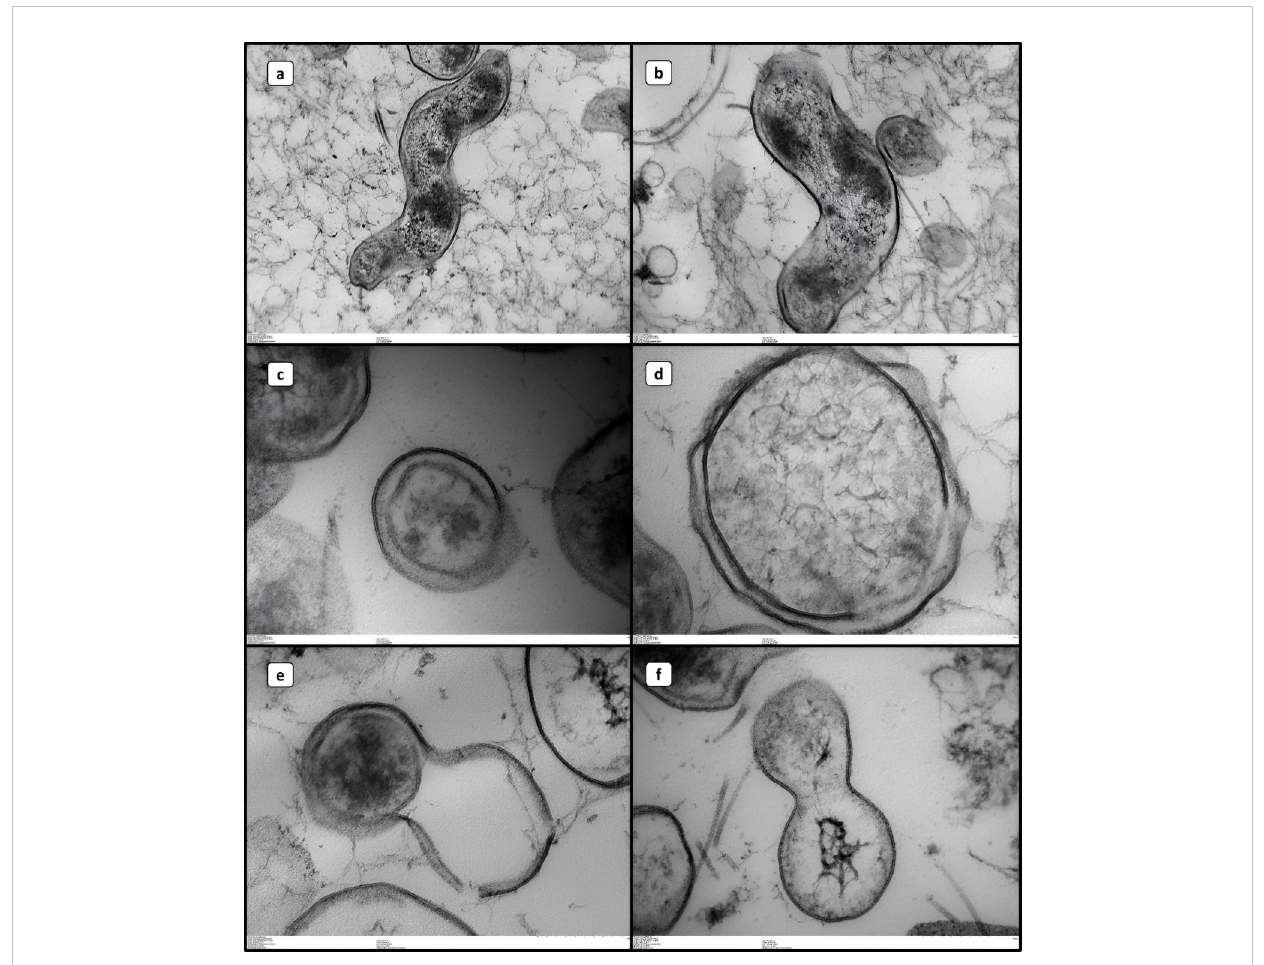
FIGURE 3 Transmission electron microscopy images of Campylobacter jejuni in different life forms. (A, B) VT. (B – F)